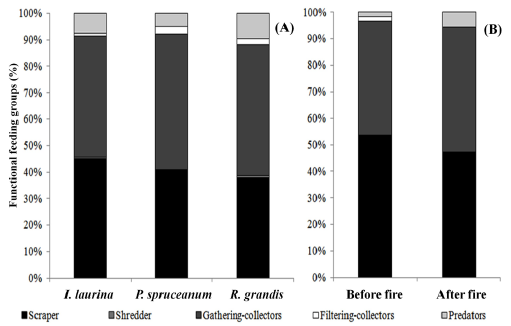
Figure 4. Percentage of functional feeding groups among different leaf litter (A) before and after fire (B) in a stream in an ecotone between Savannah and Tropical Rain Forrest.